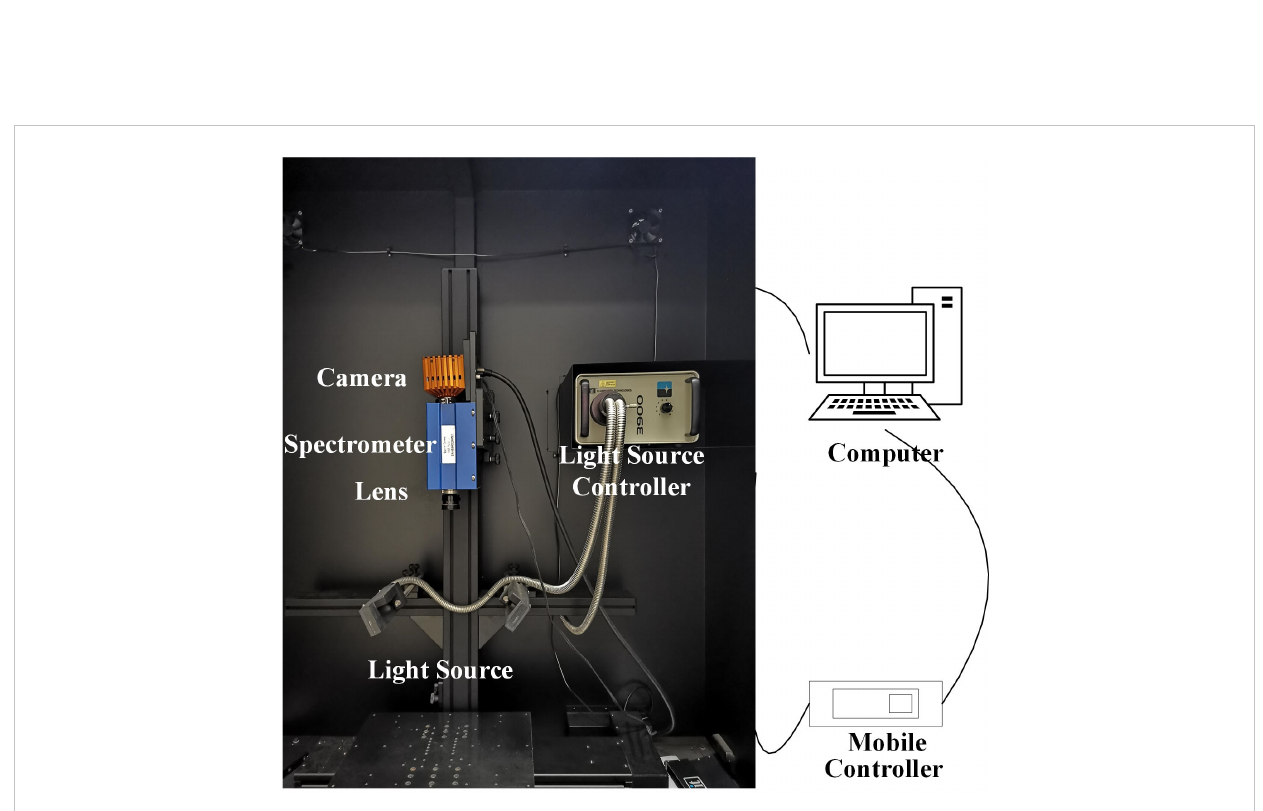
FIGURE 2 The hyperspectral imaging